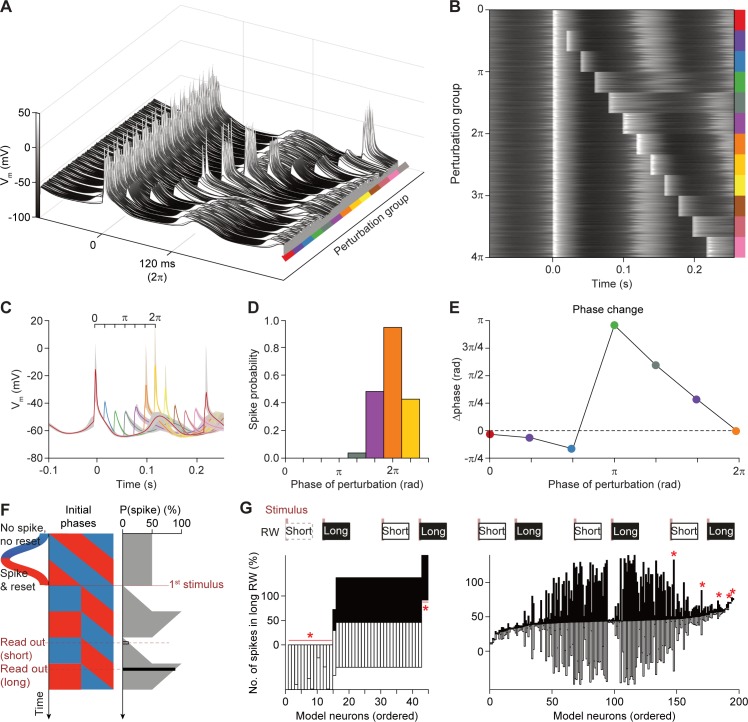
Synaptic input determines the phase-dependent gating properties of the inferior olive network model.(A) Phase-dependent spiking was prominent in our network model of the inferior olive in the absence of contextual input. We repeatedly stimulated the same 54 model cells with synchronous sensory input (cf. Fig 5A). The other 146 neurons of the network model were present, but not directly stimulated. Phase-dependent gating was studied using tandem stimulation with varying inter-stimulus intervals. The membrane potential of each of these 54 model neurons is plotted in A as a waterfall plot and in B as a heat map. The simulations are grouped by the interval between the two stimuli, starting with a single stimulation (red), and continuing with two stimuli with small to large intervals. In 13 equal steps two whole cycles of the subthreshold oscillation were covered. (C) Average and inter-quartile range (shaded area) of membrane potentials of neurons in the network that were only perturbed once at 0 ms (red) or twice (other colors). The phase of the subthreshold oscillations of the “synchronized” cells in the network was used to compute the data displayed in D and E. Note that the average membrane potential at the perturbation at 0 ms only went up to -15 mV and not up to the average spike peak of approximately 10 mV, because in the population only a fraction of neurons spiked. (D) Spike probability plot as measured for the second perturbation at the different phases of the membrane oscillation. Spike probability was computed as the number of neurons firing divided over the total number of neurons getting input. The first perturbation given at the peak of the oscillation is demarked as the start of the oscillation cycle. Perturbations at both a half and one-and-a half cycle (π and 3π, respectively) did not trigger spikes, whereas perturbations at either one or two full oscillation cycles (2π and 4π, respectively) did (see also A and B). The repetition of the ‘sinusoidal’ probability curve shows that gating is not (only) due to a refractory period, but follows the hyperpolarized phase of the oscillation (not shown). (E) Phase response curve showing that perturbations early in the oscillation phase did not have a large impact on the timing of the spike, but halfway the oscillation the perturbations advanced the ongoing phase considerably, with impact declining linearly to the end of the full cycle. (F) Gallop stimuli provide indirect evidence for an underlying oscillatory process. This idealized diagram illustrates the impact of a resetting stimulus on the future spiking probabilities. Here we assume that resetting spikes occur only during the rising phases of the STO (red) and not during the falling phases (blue). One can query for the impact on spiking probability for any given initial phase at any time after the first stimulus. Different intervals lead to biased response ratios. (G) In order to test the impact of the presumed phase of the inferior olivary neurons, we applied a “gallop” stimulation pattern, alternating short (250 ms) and long (400 ms) intervals (top row). “Sensory input” (vertical red shaded bars) were delivered and spikes were counted in response windows (RW) 0–180 ms post-stimulus. Response probabilities were compared between response windows (RW) in short (empty bars) and long intervals (filled bars). Many cells in the model prefer either the short or the long window (for spiking cells, see left lower panel). However, in the presence of contextual noise, this preference largely washes off, seen as approximately symmetric responses in each of the intervals. Asterisks indicate that a tiny fraction of cells still displayed significant preference for particular intervals, which could be attributed to the low number of spikes fired by these cells.